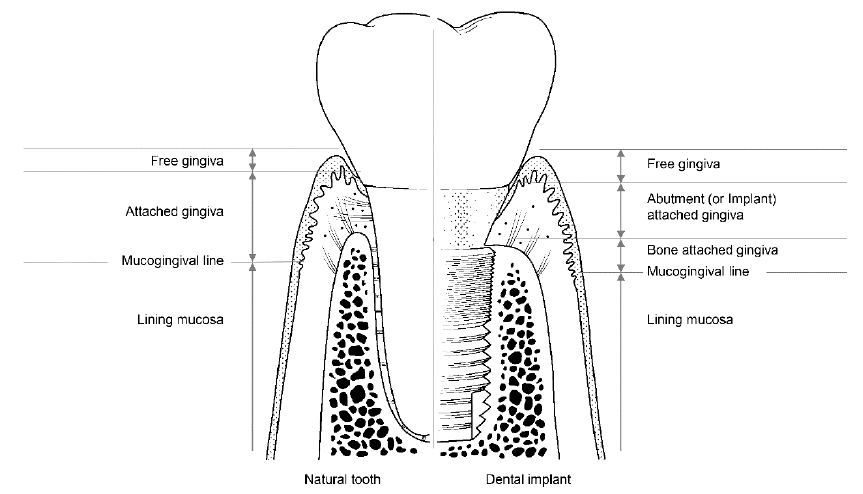
Figure 3. The structure of soft tissue around a natural tooth ( left ) and a dental implant ( right ).